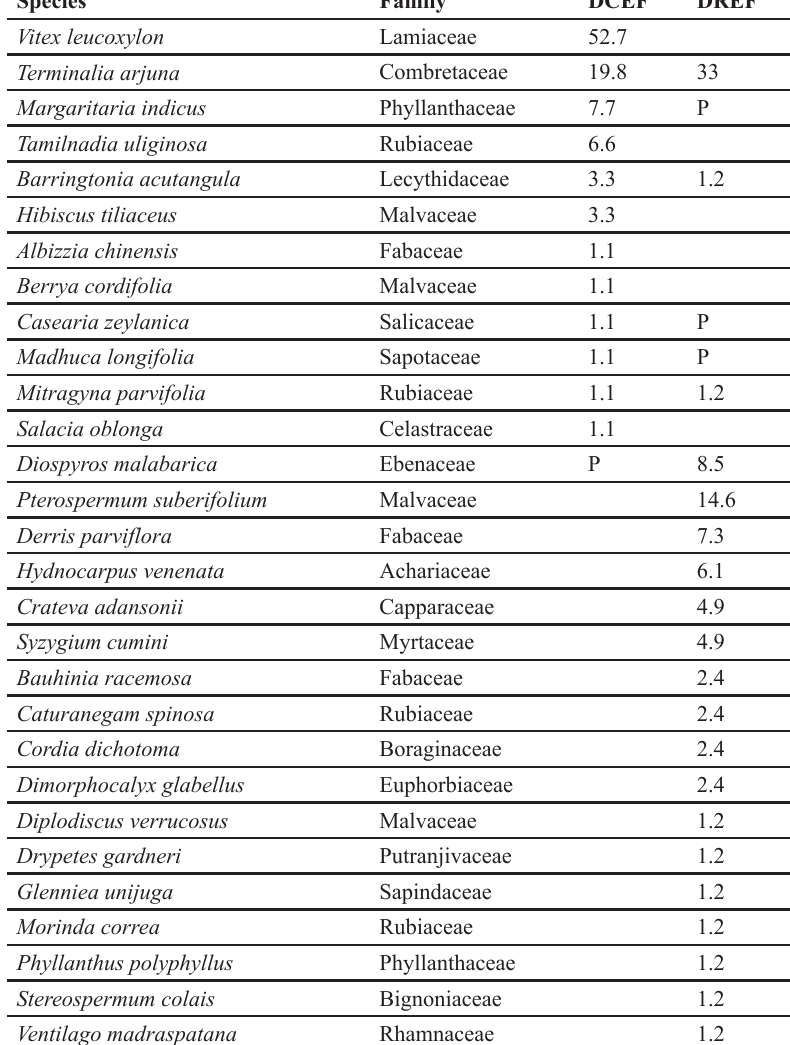
Table 2: Percentage Species Density in Dry Canal-associated Evergreen Forest (DCEF) and Dry Riverine Evergreen Forest